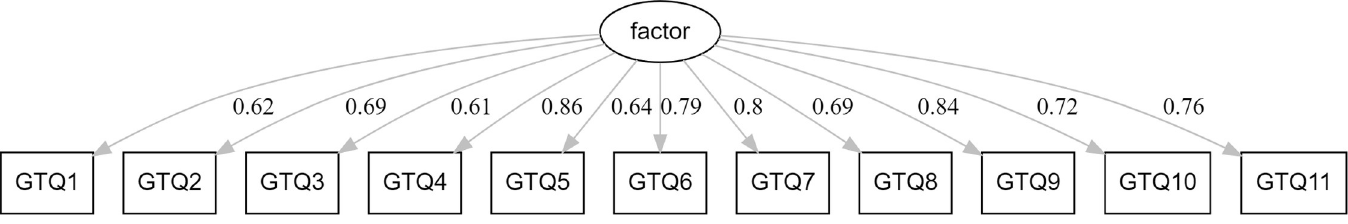
Fig 3. Standardized solution of the GTQ one-factor model in a Polish